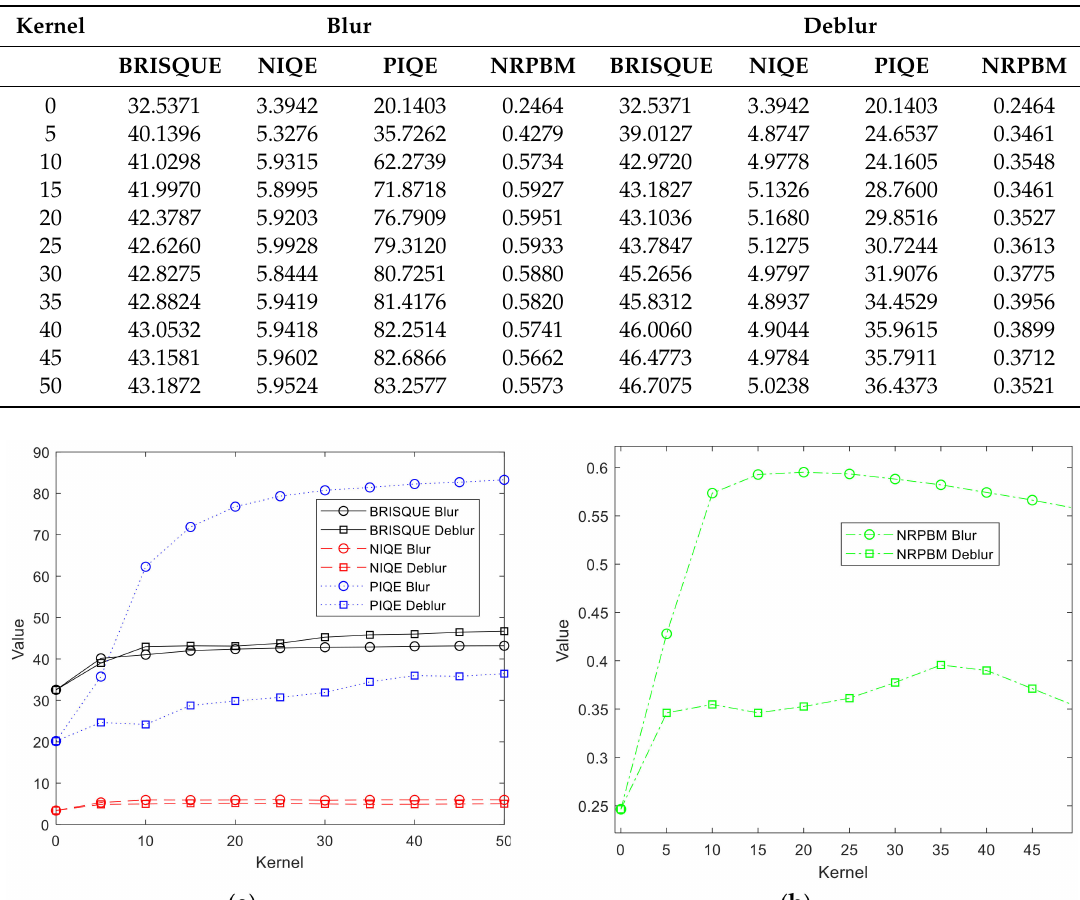
Table 5. Calculated image quality evaluator scores.